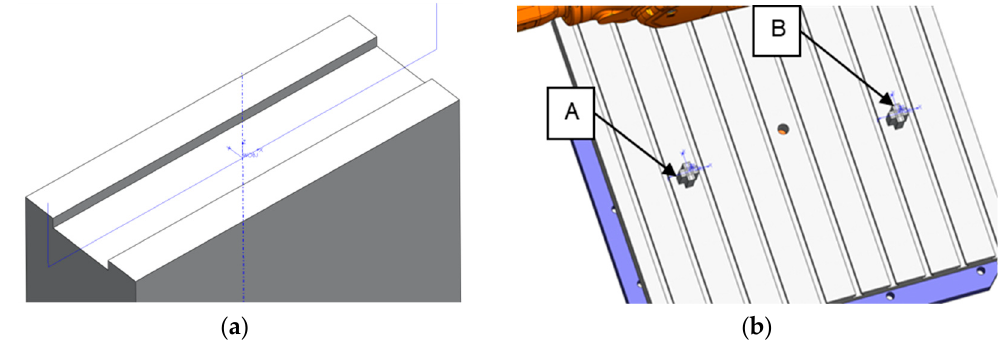
Figure 3. ( a ) Image of CAD model of workpiece; ( b ) workpiece locations in position A and B.